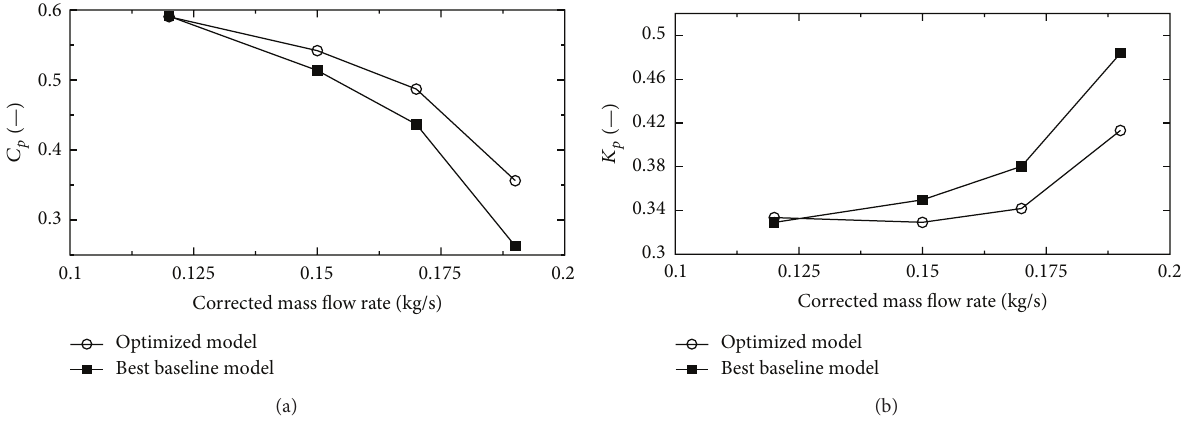
Figure16:Staticpressurerecoverycoefficient(a)andtotalpressurelosscoefficient(b)at 𝑛 = 100,000 min −1 forthebestbaselineandoptimized volute